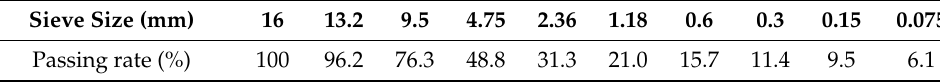
Table 6. Gradation used in the